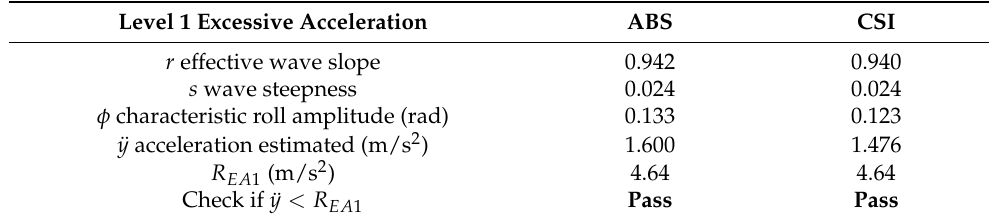
Table 17. Level 1 assessment of the excessive acceleration failure mode for C11 container